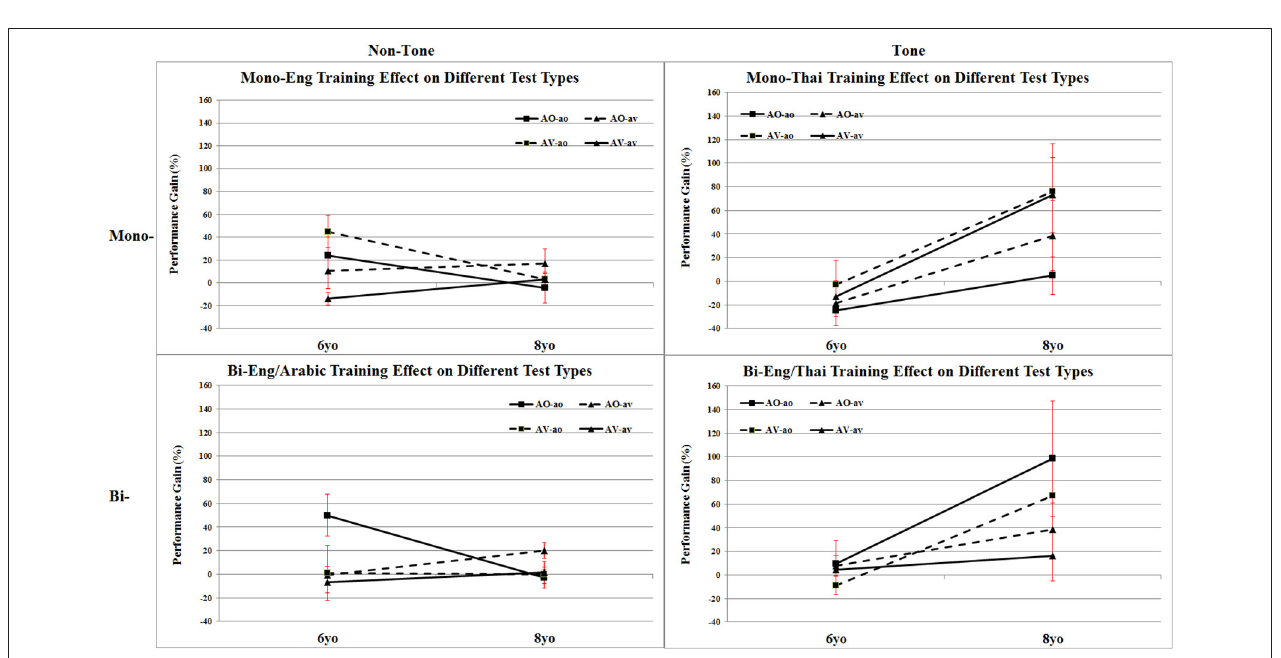
interaction for ao tests, F (1, 65) = 5.19, p < 0.03, η p² = 0.074. This